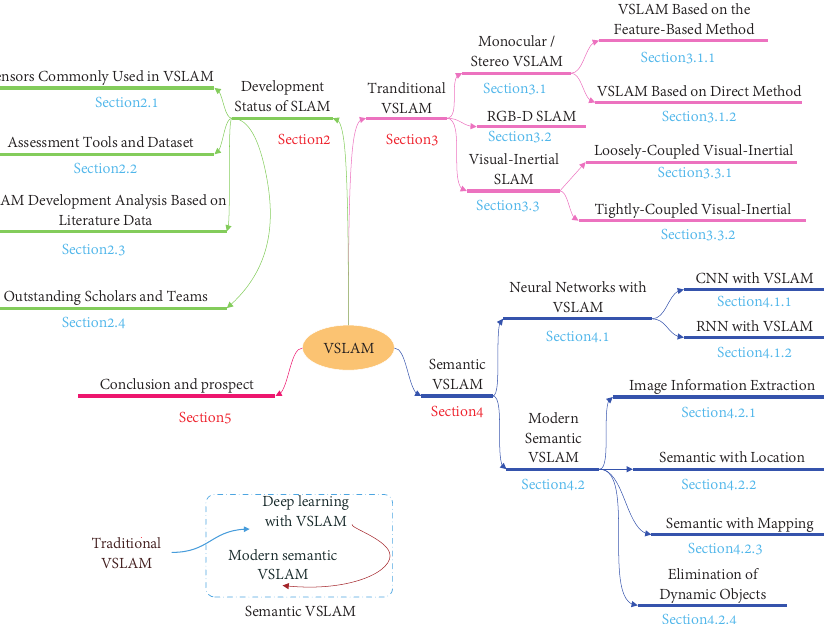
Figure 2. Structure diagram for the rest of this paper. This paper focuses on the second chapter of semantic VSLAM. We consider the introduction of neural networks as the beginning of semantic VSLAM. We start with a deep neural network, describe its combination with VSLAM, and then explain modern semantic VSLAM in detail from the aspects of object detection and semantic segmentation based on deep learning, and make a summary and